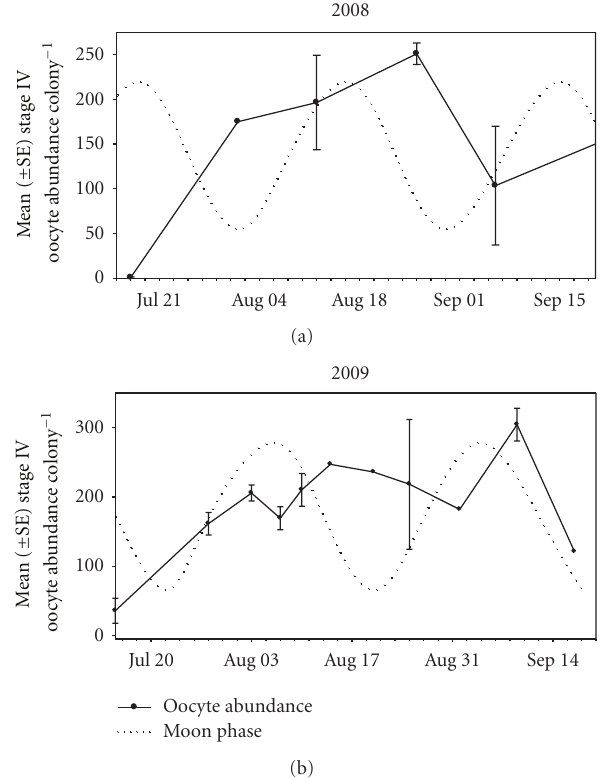
Figure 13: Stephanocoenia intersepta mean ( ± SE) abundance of stage IV oocytes per colony at each sampling date plotted with moon phases for years 2008 and 2009; full moons represented by peaks in moon phase